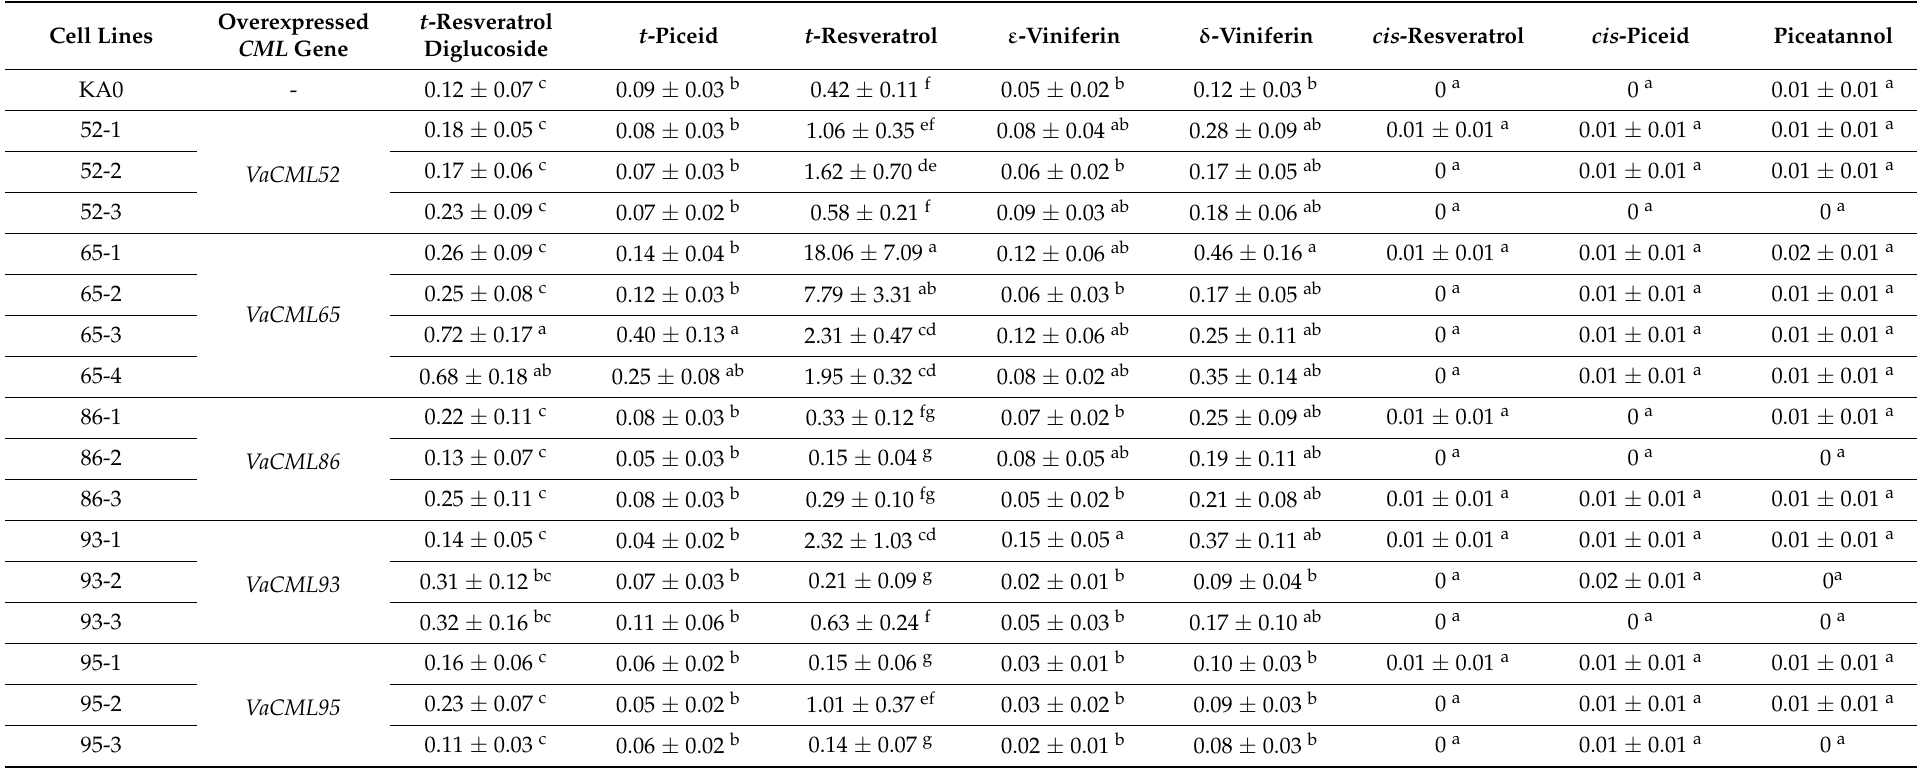
Table 2. The content of individual stilbenes (mg per g of the dry weight (DW)) in the transgenic Vitis amurensis cell lines transformed with VaCML52 , VaCML65 , VaCML86 , VaCML93 , or VaCML95